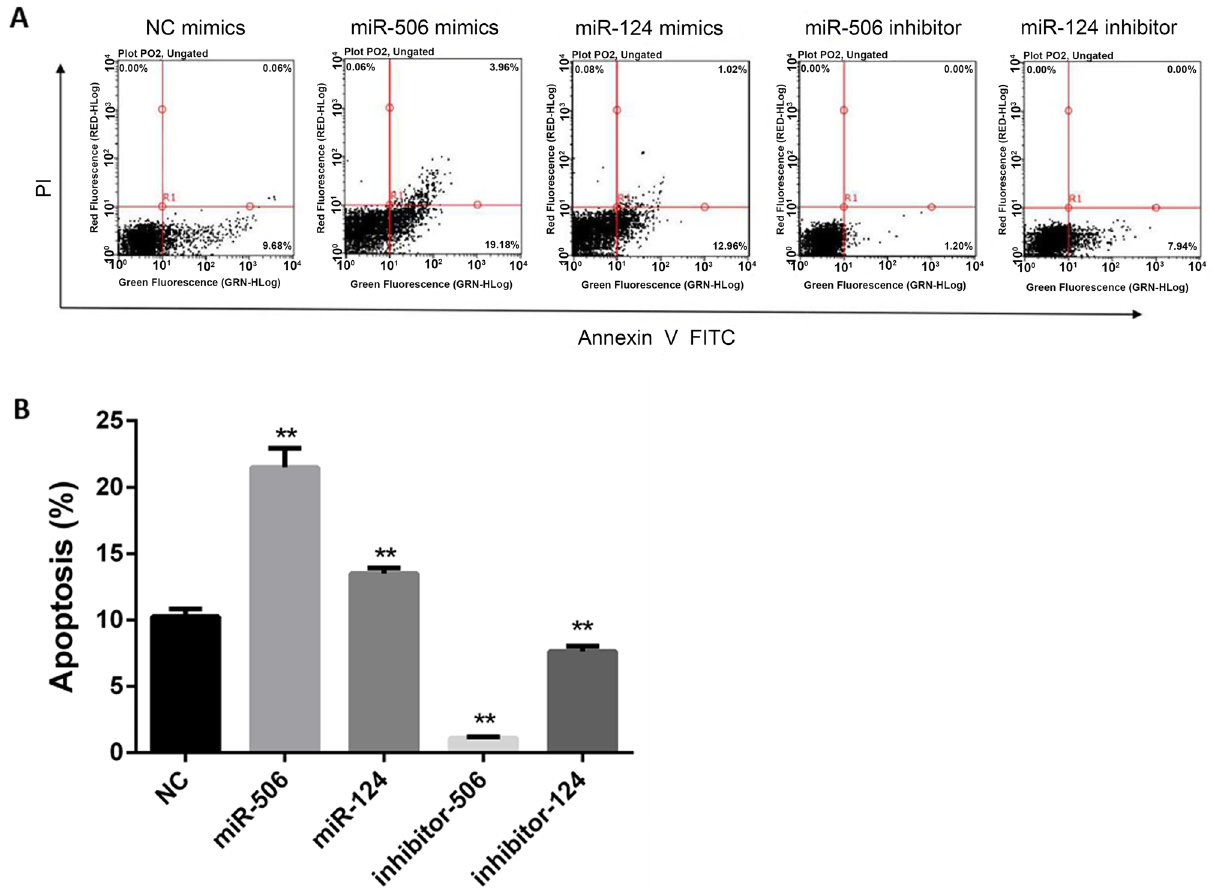
Figure 4. Role of miR-506 and miR-124 on apoptosis of HL-7702 cells. ( A ) Flow diagram of apoptosis of HL-7702 cells transfected with miR-506 or miR-124 mimics, inhibitor and their negative control miRNA. ( B ) The rate of apoptotic cells among different groups. **Represents P <